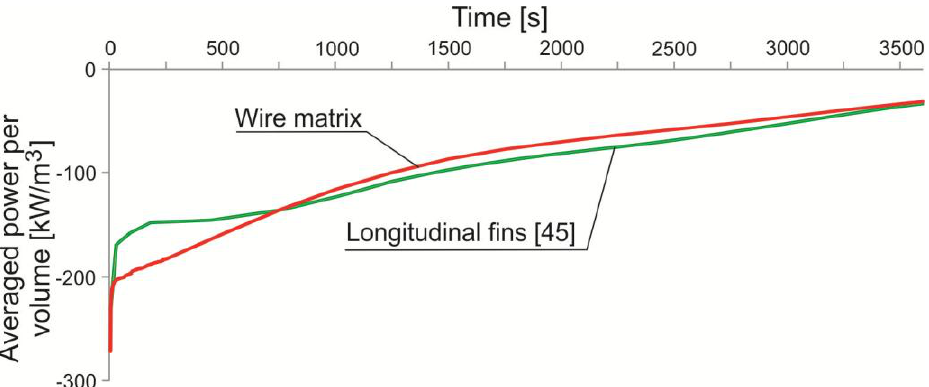
Figure 13. Chronological sequence of the volume averaged discharged power per m 3 NaNO 3 during the solidification process.